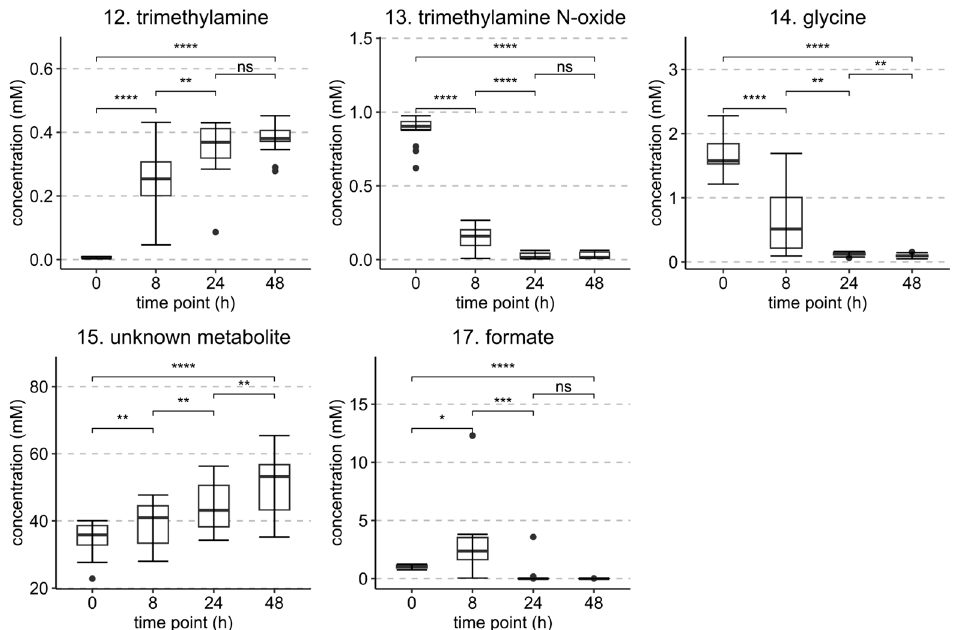
Figure 10. Statistically significant ( p < 0.05) identified metabolites and their concentrations from the fecal BC sample set at 0 h, 8 h, 24 h, and 48 h time points. Metabolites are numbered according to Table 1. p values of difference are from a paired t-test (n = 30). Levels of significance: **** p < 0.0001;